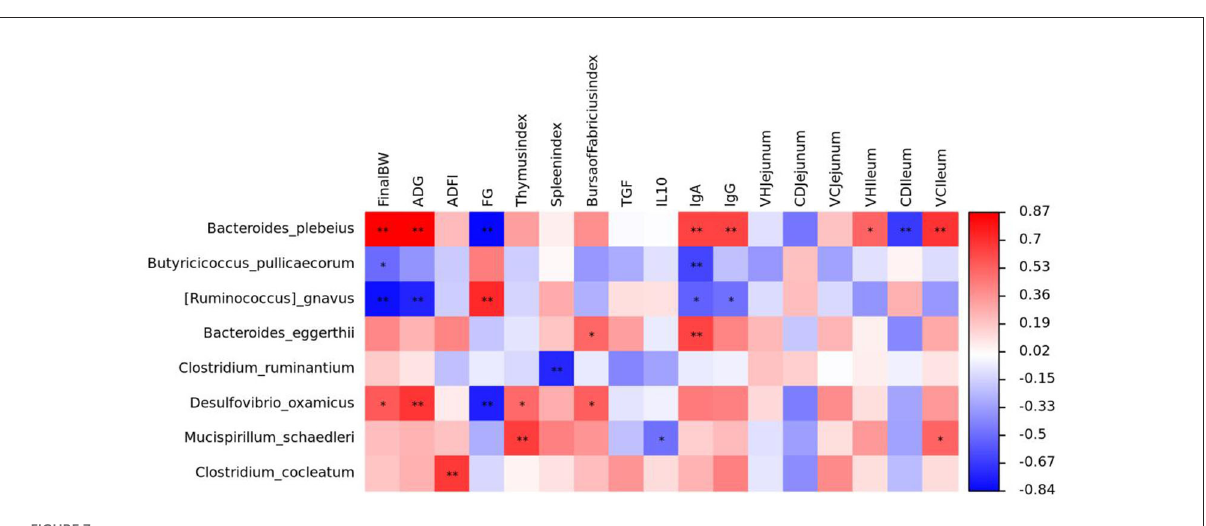
FIGURE7 Relationship between gut microbiota and main